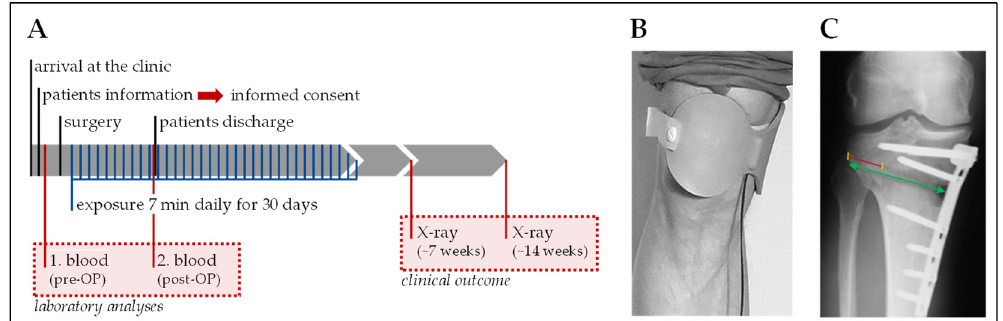
Figure 1. Overview of the study design. ( A ) Schematic overview of the study procedure. ( B ) Illustration of how the extremely low frequency pulsed electromagnetic field (ELF-PEMF) applicator (Somagen ® device) was placed during treatment. ( C ) Guideline for the quantification of osseous consolidation in high tibial osteotomy (HTO) patients [26]: the green arrow marks the osteotomy (distance A) and the red line marks the gap filling (distance B). Osseous consolidation is calculated as B/A × 100 (%).